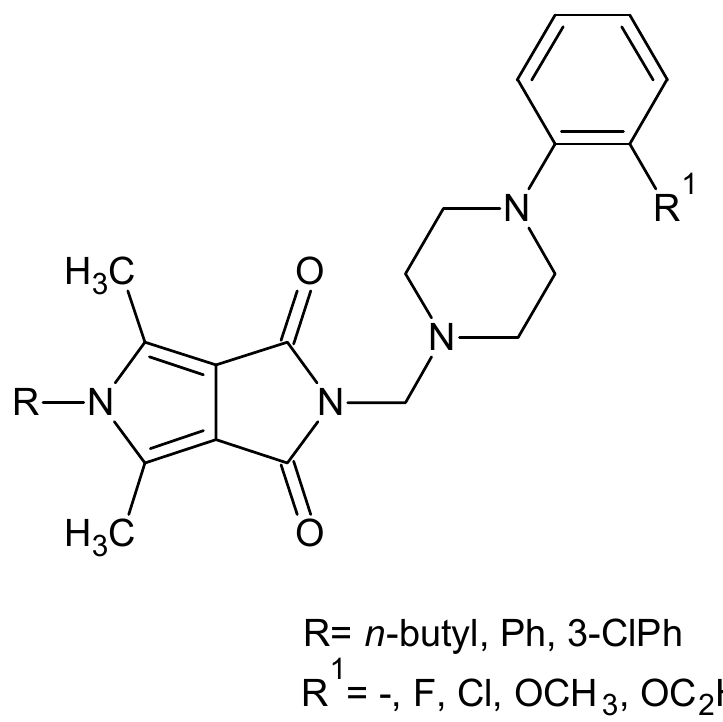
Figure 2. Pyrrolo[3,4 ‐ c ]pyrroles with activity as a COX ‐ 1 and COX ‐ 2 inhibitors. The obtained structures (Figure 2) inhibited less COX-2 and more COX-1 than the reference drug—meloxicam. Therefore, their selectivity ratio (COX-2/COX-1) was more than twice as high as meloxicam